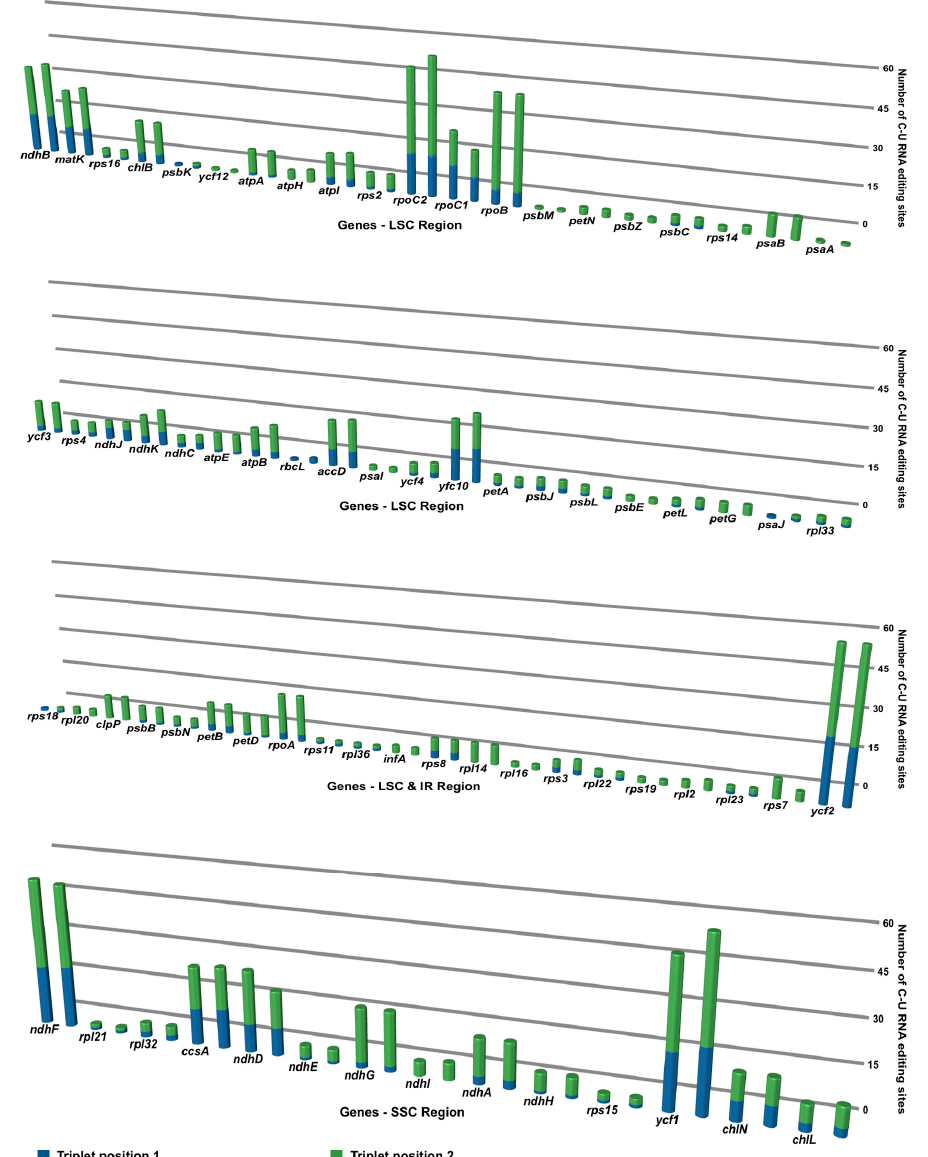
Figure 5. Triplet position and number of C-to-U RNA editing sites in plastid genes of C. falcatum and C. devexiscapulae were compared. Columns represent the protein-coding genes of C. falcatum and C. devexiscapulae , respectively. The blue cylindrical column indicates C-to-U RNA editing events that occurred in triplet position 1, whereas the green cylindrical column indicates C-to-U RNA editing events that occurred in triplet position 2.